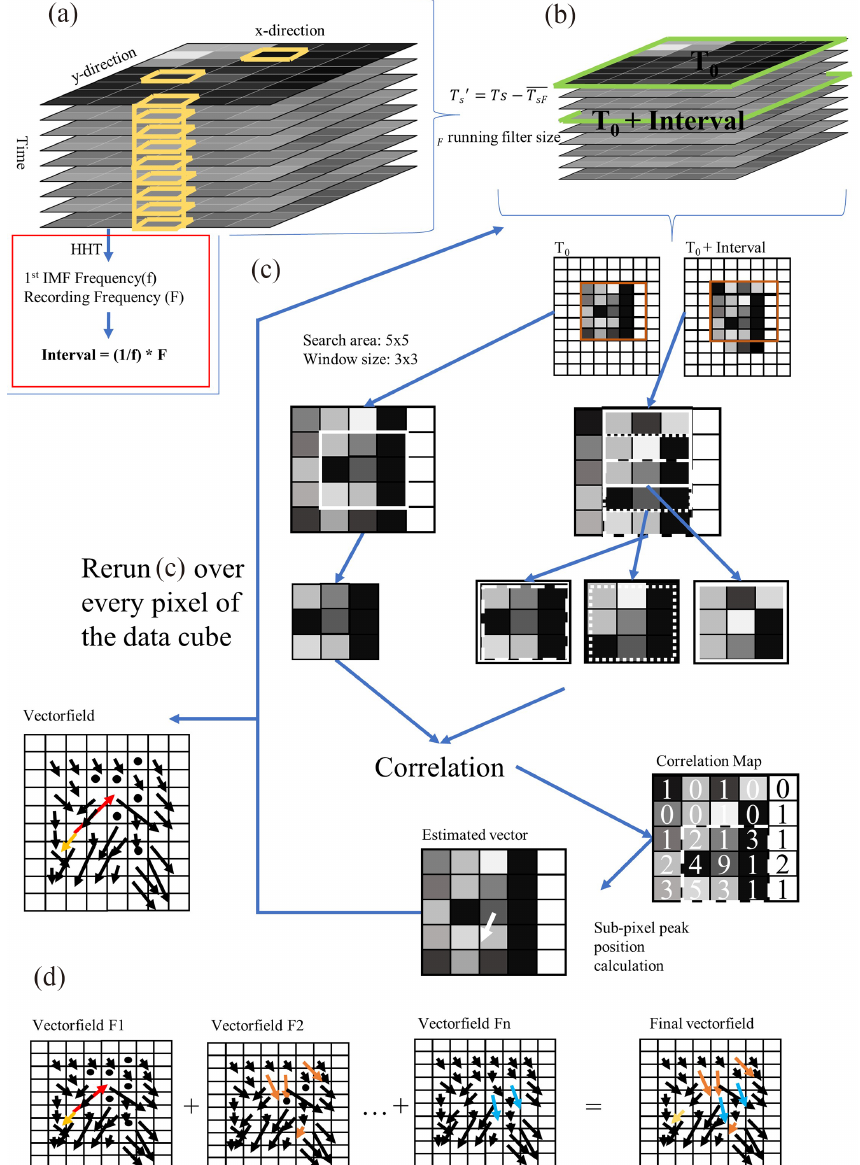
Figure 1. Schematic of the A-TIV algorithm – (a) randomly selected stabilized brightness temperature pixels (marked orange) are used with HHT to find the highest-frequency signal component of the data set which defines the interval setting. (b) The perturbation calculation with different predefined running filter sizes (F) is done to provide the data for computation of the TIV core algorithm. From the perturbation data set two images with the time increment of the interval setting are extracted and passed to panel (c) . (c) Core TIV algorithm with an example search area size of 5 × 5 pixels and a correlation window size of 3 × 3 pixels. Error vectors are adjusted using the standard deviation of the calculated vectors in the direct adjacent pixels. (d) The process from panel (c) is computed over all predefined filter sizes of panel (b) to calculate multiple vector fields that are available. Finally, all vector fields are merged using weighted